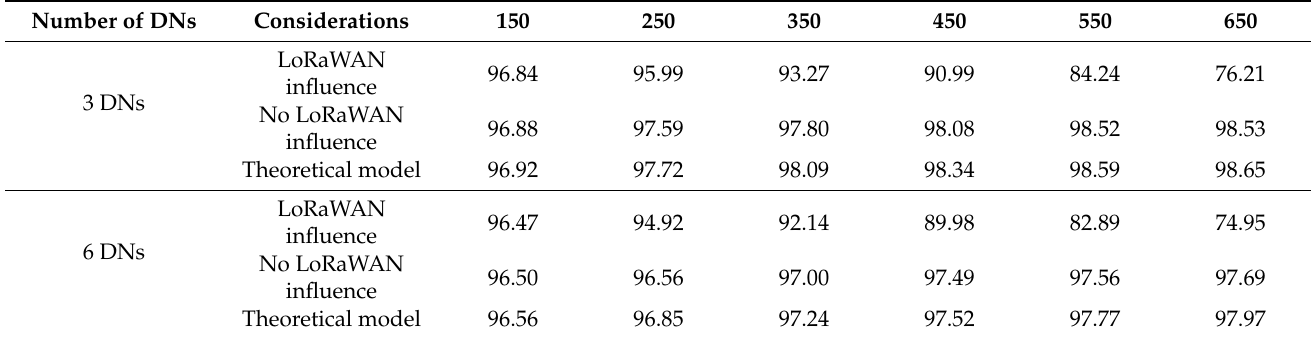
Table 7. LoRa WAN traffic influence for blind spots with three and six DNs (values in %).